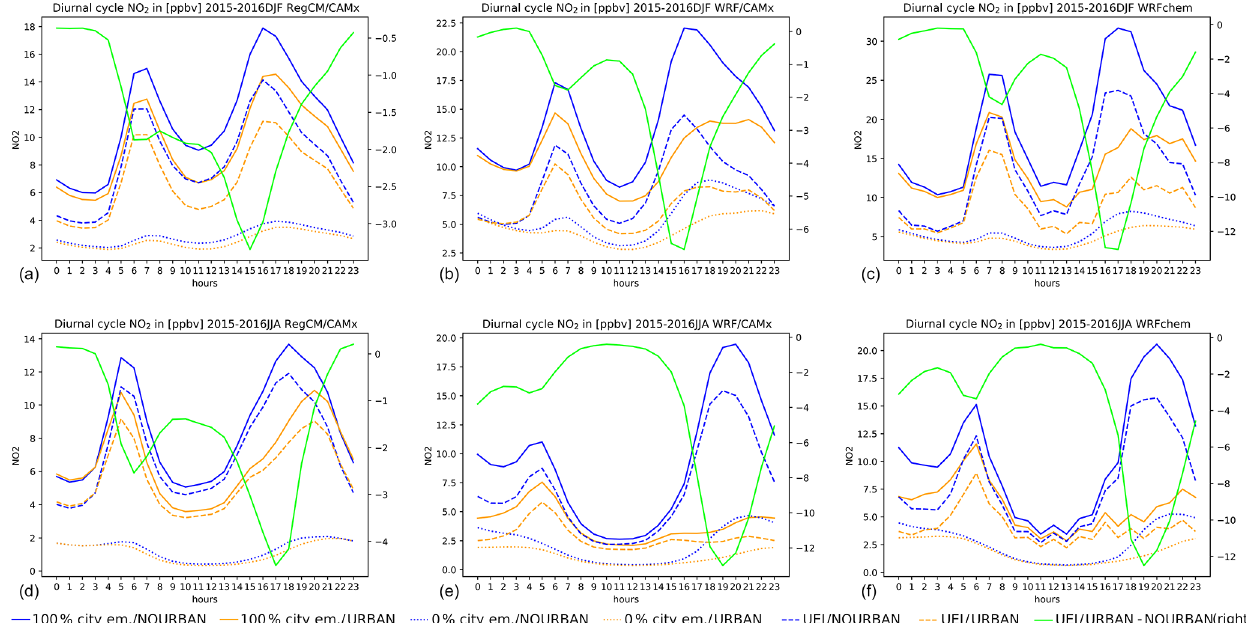
Figure 9. The average diurnal cycle of the absolute urban NO 2 concentrations and their difference between different simulations for DJF (a– c) and JJA (d–f) and for the three models applied as columns: CAMx driven by RegCM, CAMx driven by WRF and WRF-Chem. Blue and orange lines denote the NOURBAN and URBAN cases, respectively. Solid lines stand for the reference values with 100% urban emissions, dotted lines for the 0% urban emission runs and dashed ones for the UEI evaluated for both the NOURBAN and URBAN cases. These correspond to the left vertical axis. Finally, the green line denotes the (cid:49) UEI (right vertical axis), i.e., the modification of the urban emission impact due to the inclusion of the urban effects (the UCMF). Units in parts per billion volume (ppbv).